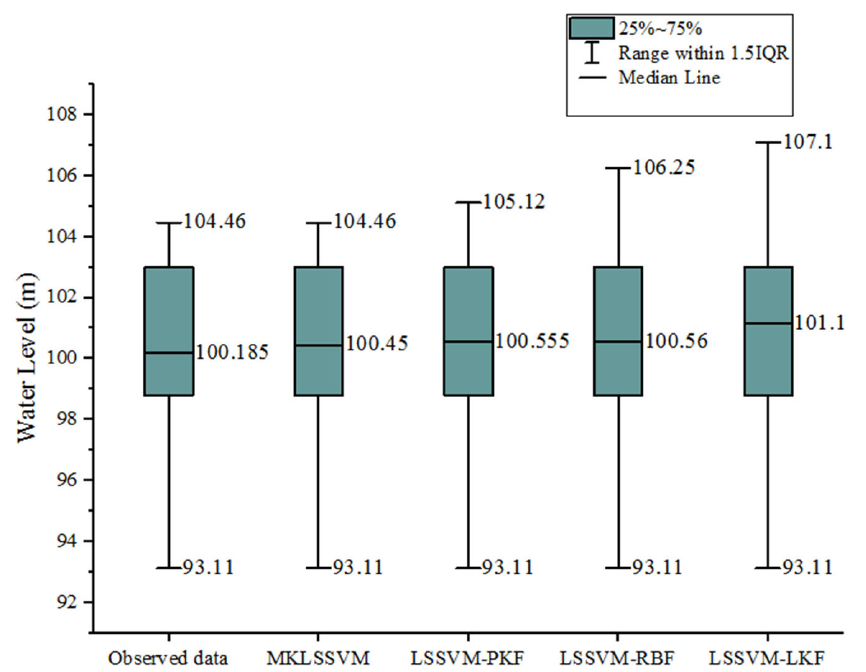
Figure 3. Boxplots of the MKLSSVM and different least square support vector machine models.